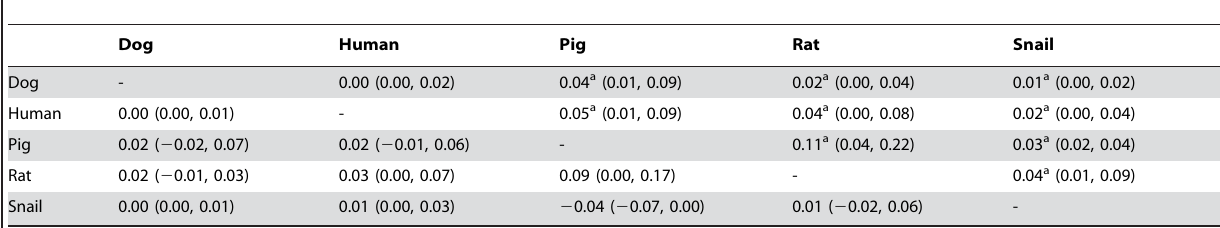
Values above the diagonal represent F Sp ST estimates not adjusting for genetic differentiation at the individual host level. Values below the diagonal represent F Sp ST estimates adjusted for genetic differentiation at the individual host level. (95% confidence intervals shown in brackets).